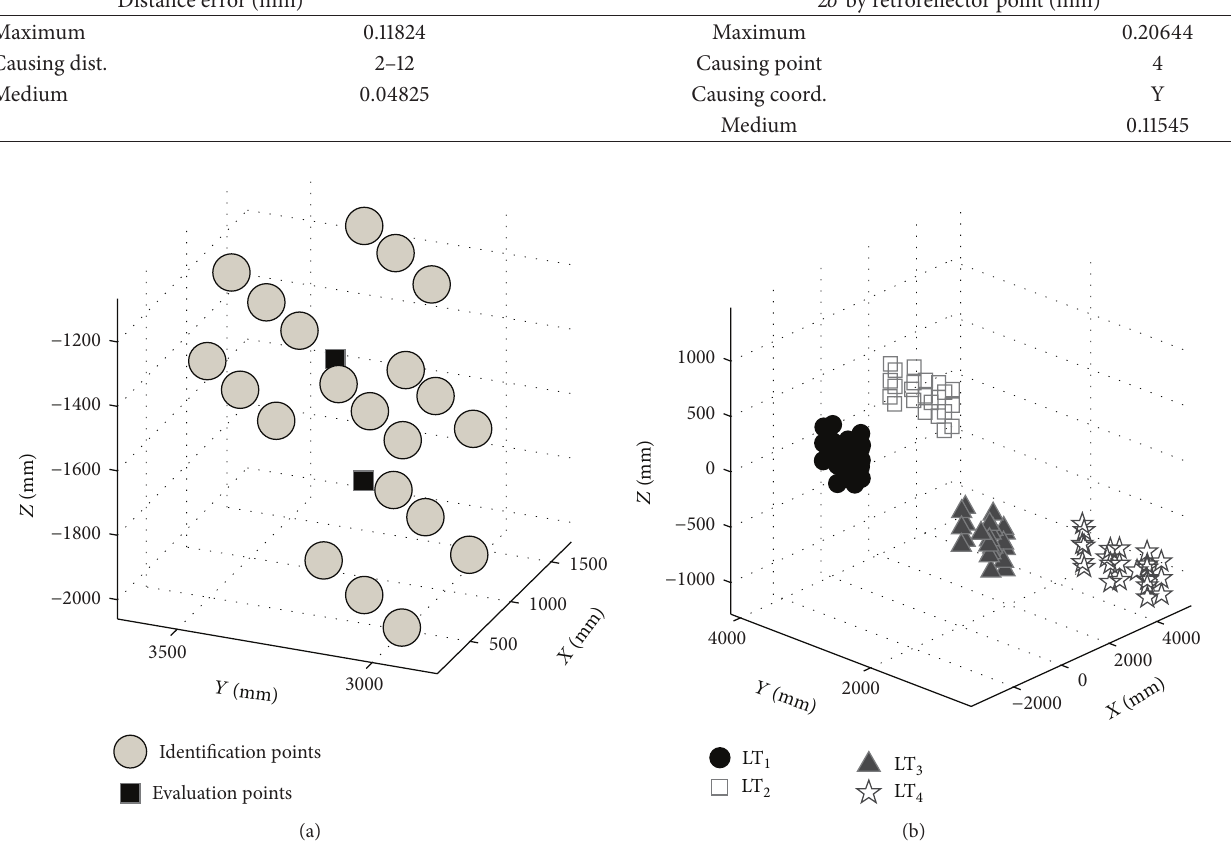
Figure 7: Points captured by LTs. (a) Multilaterated points used as nominal data for the parameter identification procedure; (b) points captured by each LT.